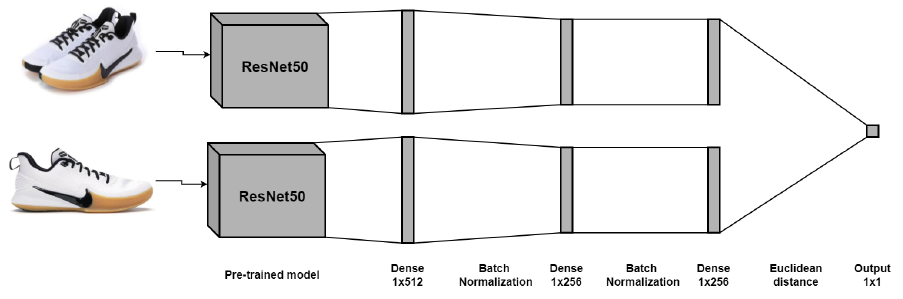
Figure 6. Image-Siamese architecture for images of